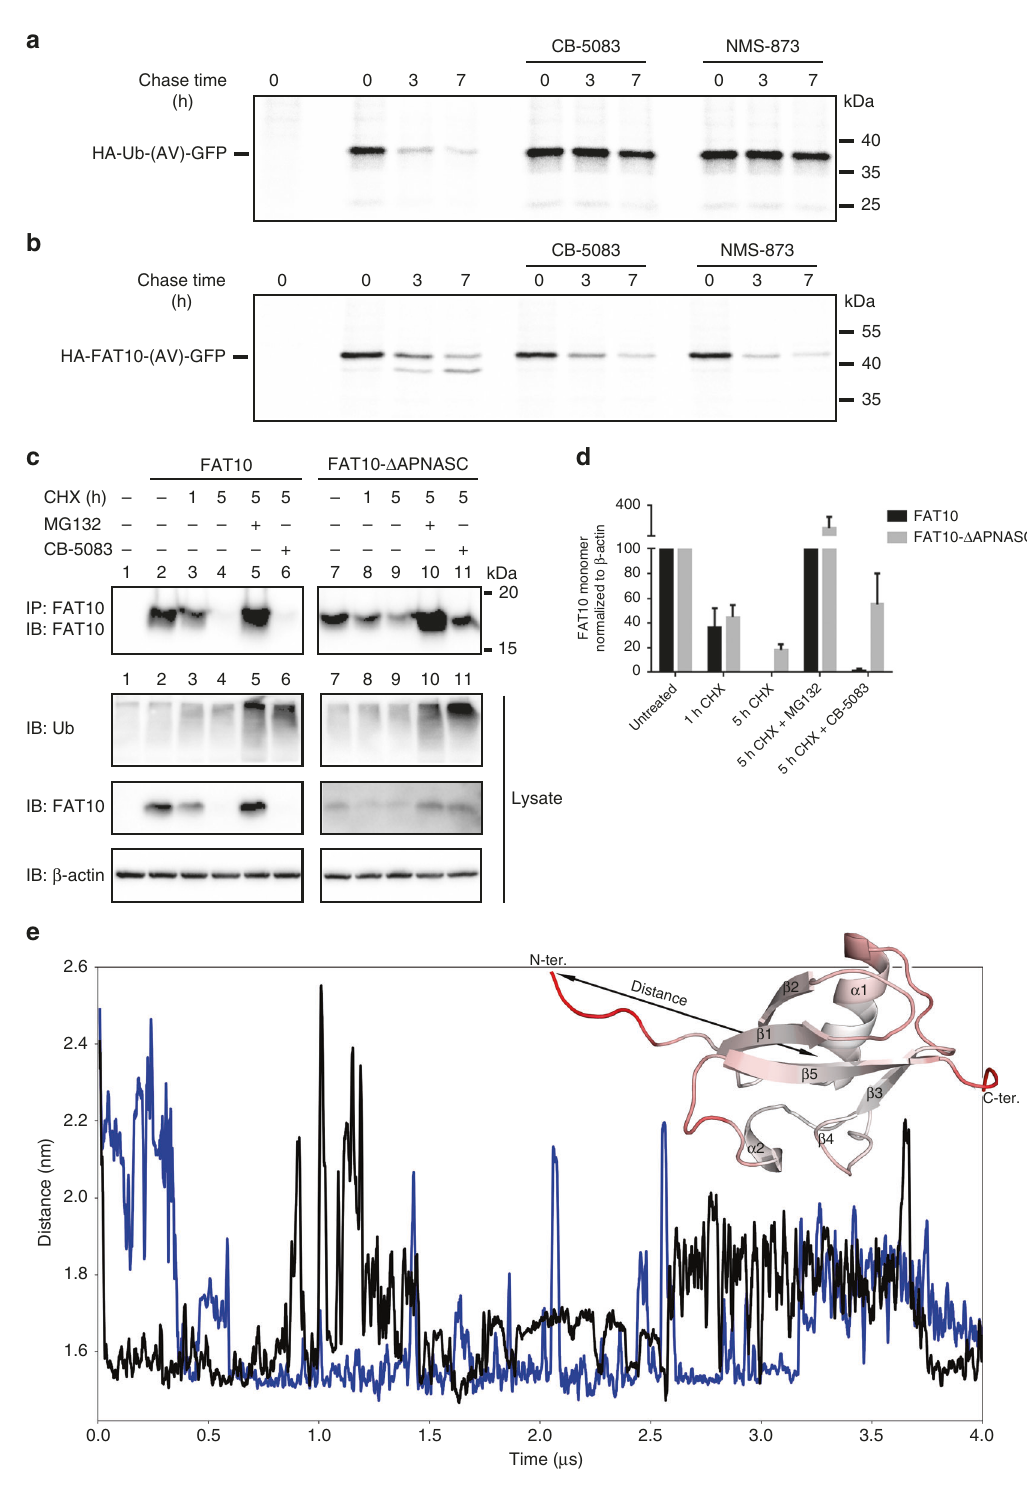
HNH-, HCH- and CNH- and 2D NOESY spectra 43 using a 1.2mM sample recorded at 800MHz using a mixing time of 120 ms. Dihedral angle restraints for backbone φ and ψ angles were derived from chemical shifts using TALOS 44 . Hydrogen bonds were identi fi ed in NOESY spectra and set to 1.8Å for H N – O and 2.8Å for N – O distances. All spectra were processed with the NMRPipe/NMRDraw package 45 and analyzed with CARA/XEasy 46 . Structures were calculated using ARIA1.2 47 . Ramachandran plot statistics were obtained with PROCHECK-NMR using residues 87 – 160 of the ten lowest energy struictures. 90.2% of all residues were in favored regions and 9.8% of all residues were in additional allowed regions